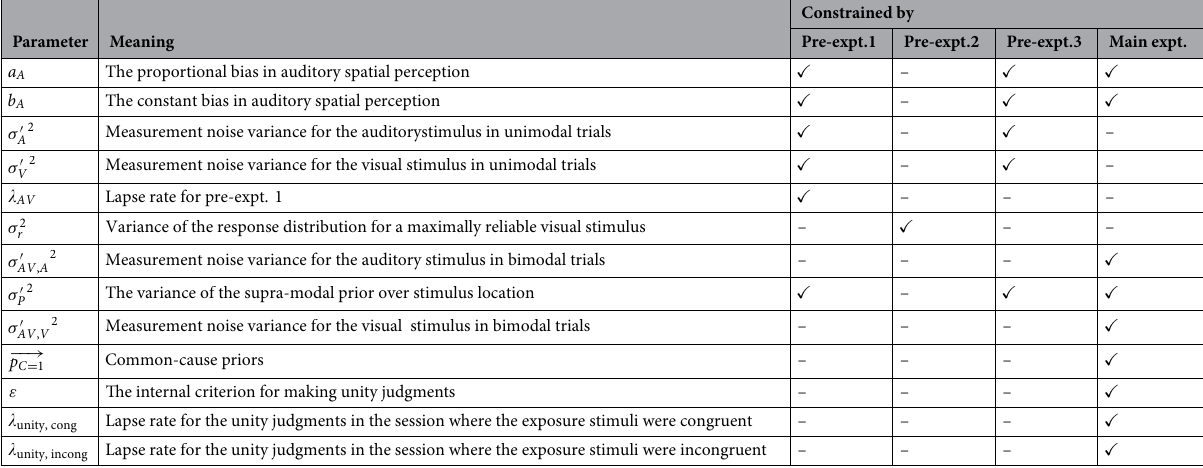
Table 2. Summary of model parameters and parameter